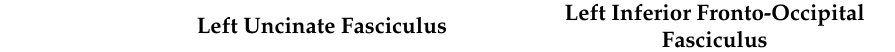
Figure 2. Voxel-wise Tract-Based Spatial Statistics differences in FA metrics between group. As UF and IFOF traverse the temporal lobe, which is closely related to the post- traumatic cognitive function and psychiatric symptoms, we further explored the relation- ship between these two fiber tracks and the GM structures of the temporal gyrus and medial temporal lobe. GM volumes were significantly related to the FA of left UF and left IFOF in multiple regions of left temporal gyrus and left hippocampus (Table 5). No statistically significant association was found between SLF and the GM volumes of the supplementary motor area. Table 5. The relationship between fractional anisotropy and GM volume in the temporal gyrus and medial temporal lobe of TBI